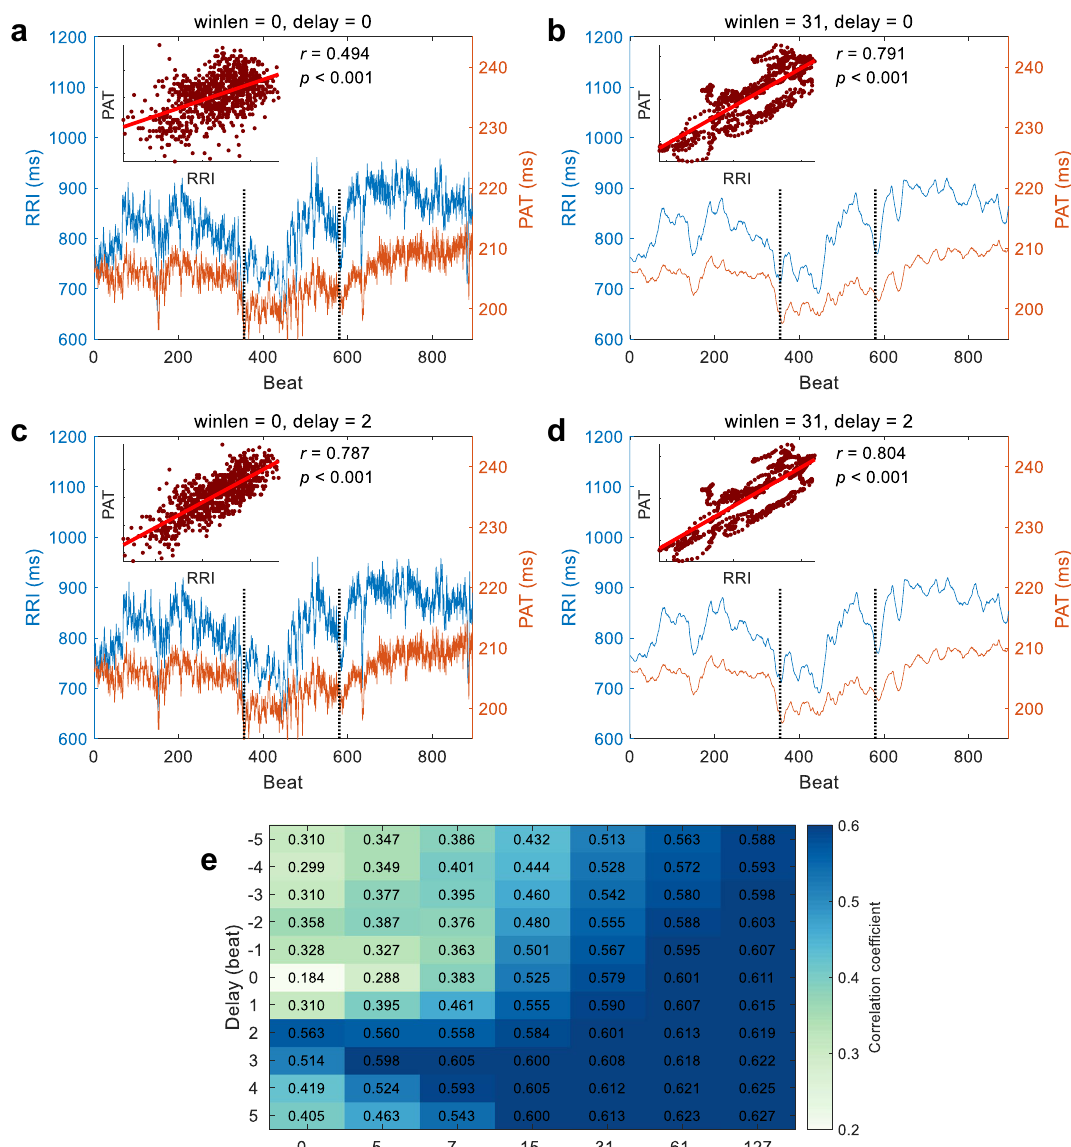
Figure 6. Correlation between RRI and PAT under cold stimulation. ( a – d ) A typical example of RRI and PAT series from one subject under the cold stimulation. The dotted vertical lines indicate the beginning and the end of the cold stimulation. winlen, the window length of the Savitzky-Golay filter (winlen = 0, no smoothing). delay, the delayed beats of RRI series. r, the correlation coefficient. ( e ) The correlation coefficients between RRI and PAT with different delays and different smoothness for all subjects in the cold stimulation. The presented data are averaged over all subjects. Window length, the window length of the Savitzky-Golay filter (if 0, no smoothing). delay, the delayed beats of RRI